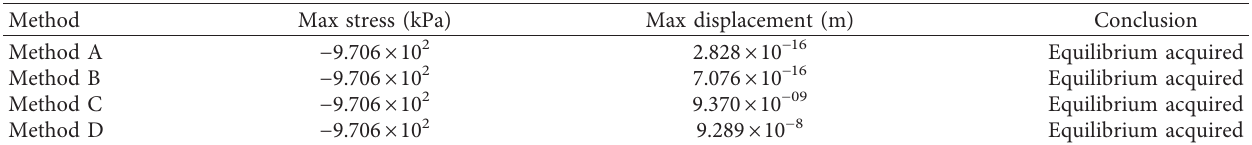
Figure 4: Stress results for model 1 (unit: kPa). (a) Method A, (b) method B, (c) method C, and (d) method D. Table 2: Table of the simulation